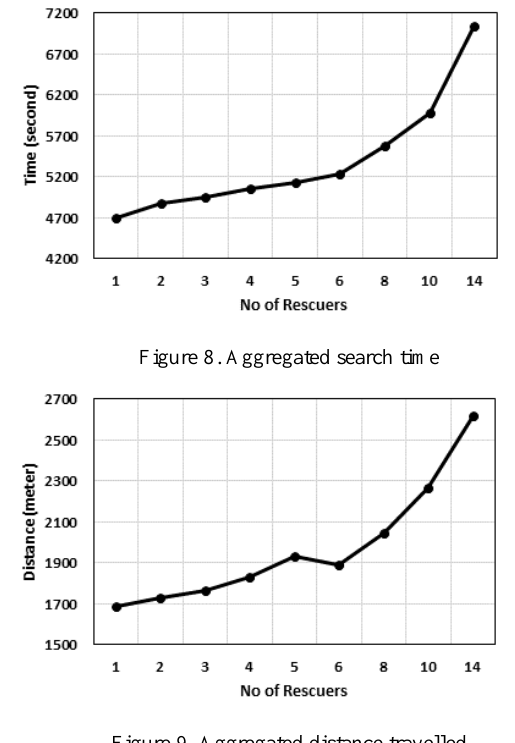
Figure 9. Aggregated distance travelled